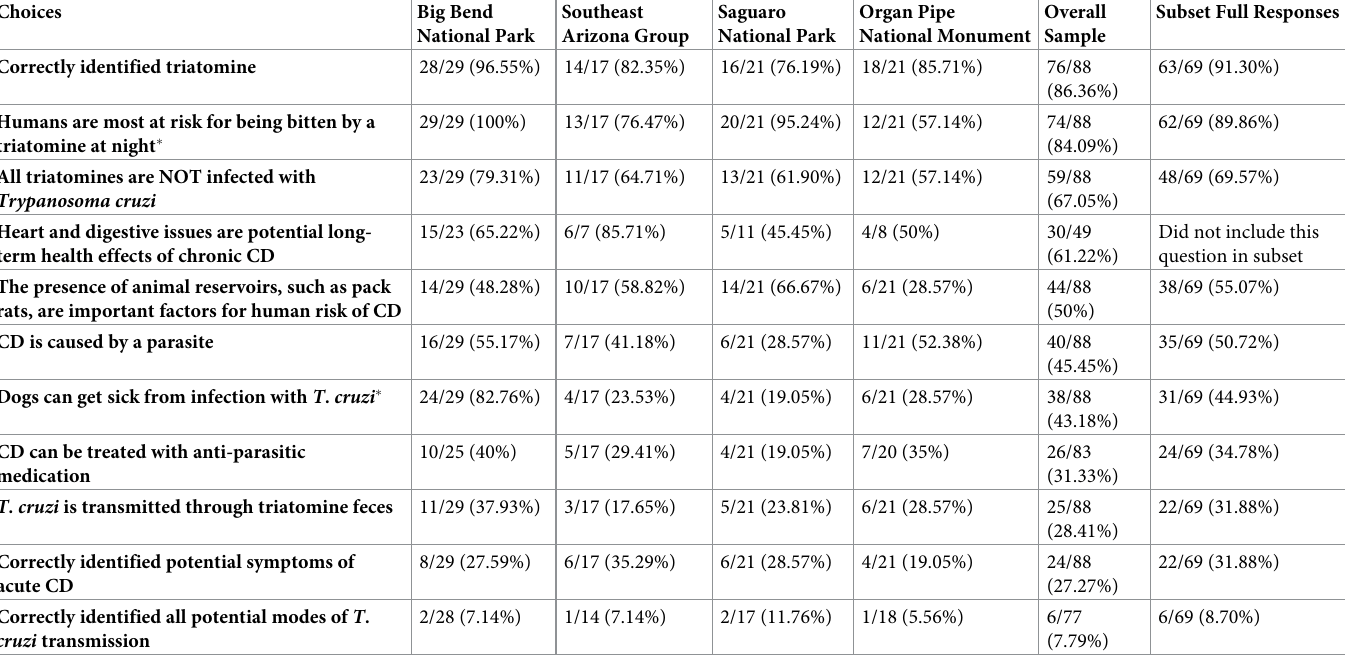
Table 2. Percent of individuals choosing correct knowledge section responses by